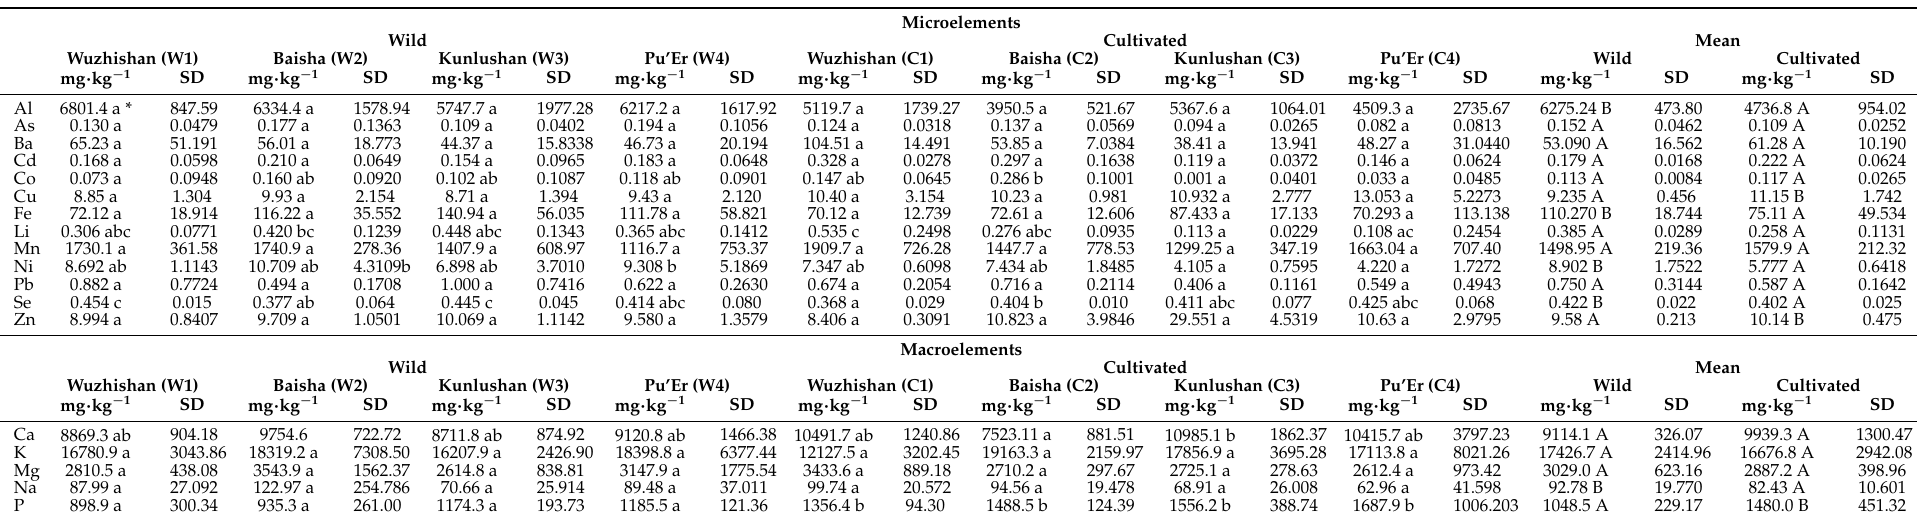
Table 2. Mean concentration of micro- and macroelements in dry tea material (mg · kg − 1